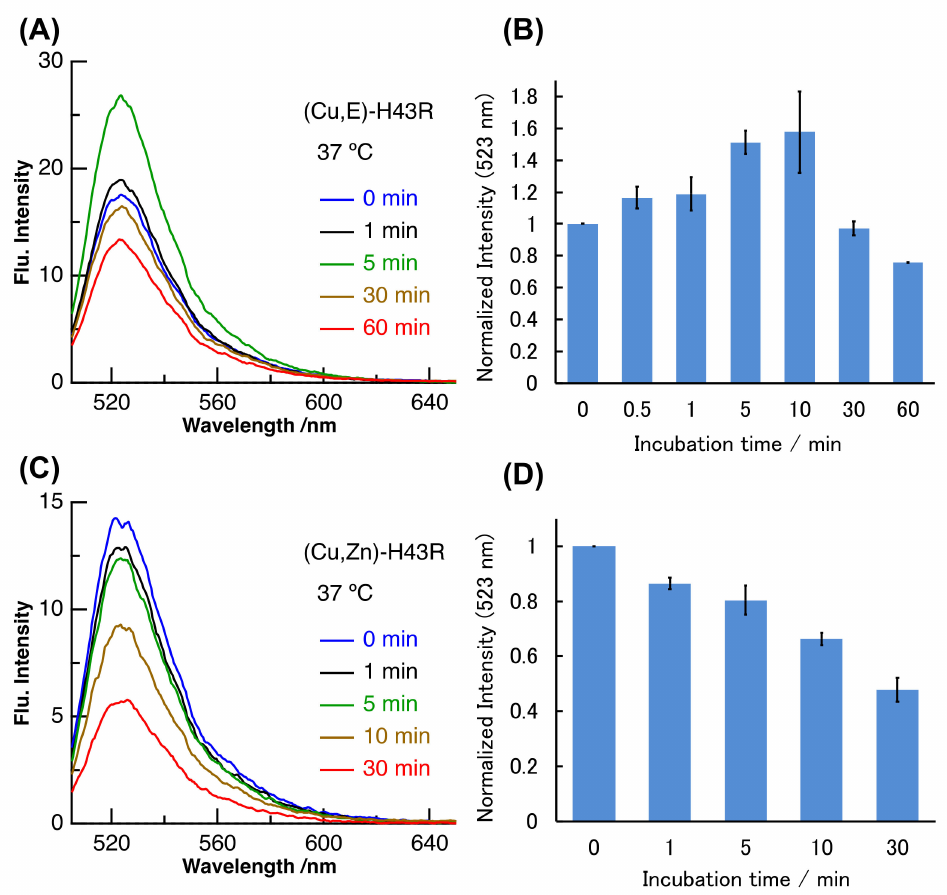
Figure 3. Pro-oxidant activities after di ff erent incubation times in phosphate bu ff er. ( A , B ): (Cu,E)-H43R at 37 ◦ C, ( C , D ): (Cu,Zn)-H43R at 37 ◦ C. The DCF fluorescence intensities normalized by the value at 0 min for ( A ) and ( C ) are shown in ( B ) and ( D ), respectively. Error bars are SE ( n = 3). Pro-oxidant activity was measured by the fluorescence intensity of DCF generated by the oxidation of DCFH (50 µ M) by protein (10 µ M) and H 2 O 2 (50 µ M) at room temperature.